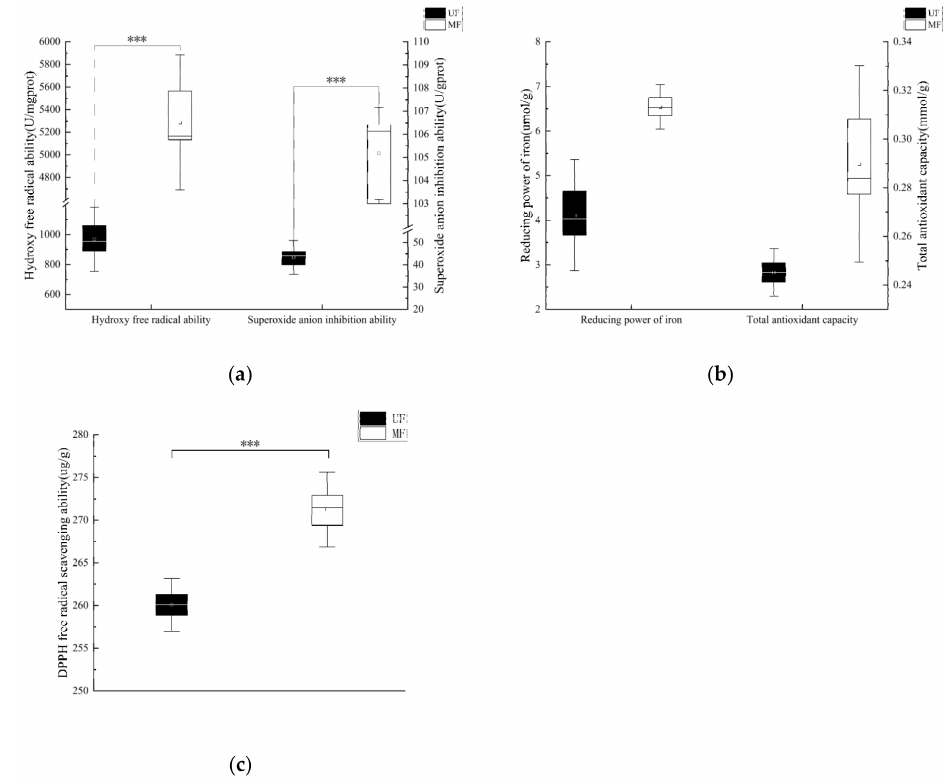
Figure 6. Analysis of the antioxidant capacity of mixed fermentation-modified soybean residue. ( a ) superoxide anion inhibition ability and hydroxy free radical ability; ( b ) reducing power of iron and total antioxidant capacity; ( c ) DPPH free radical scavenging ability. UF, unfermented soybean residue; MF, mixed fermented soybean residue. *** p <